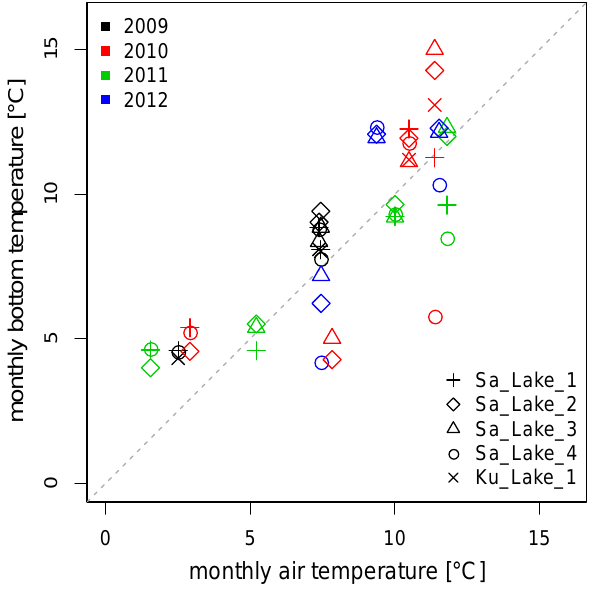
Figure 6. Relationship between mean monthly lake bottom tem- peratures for all five lakes during the ice-free period and the corre- sponding mean monthly air temperatures, from July 2009 to August 2012. Data are also provided in the Supplement of this